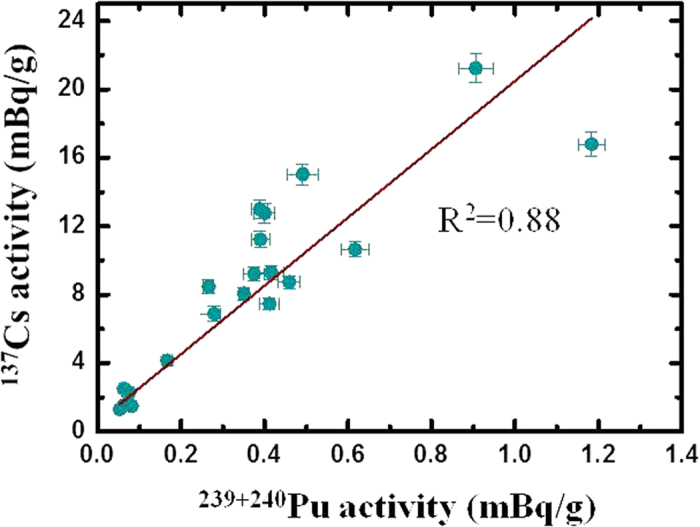
239+240Pu activity vs. 137Cs activity in the soil cores YM1, GZ2 and GZ3.